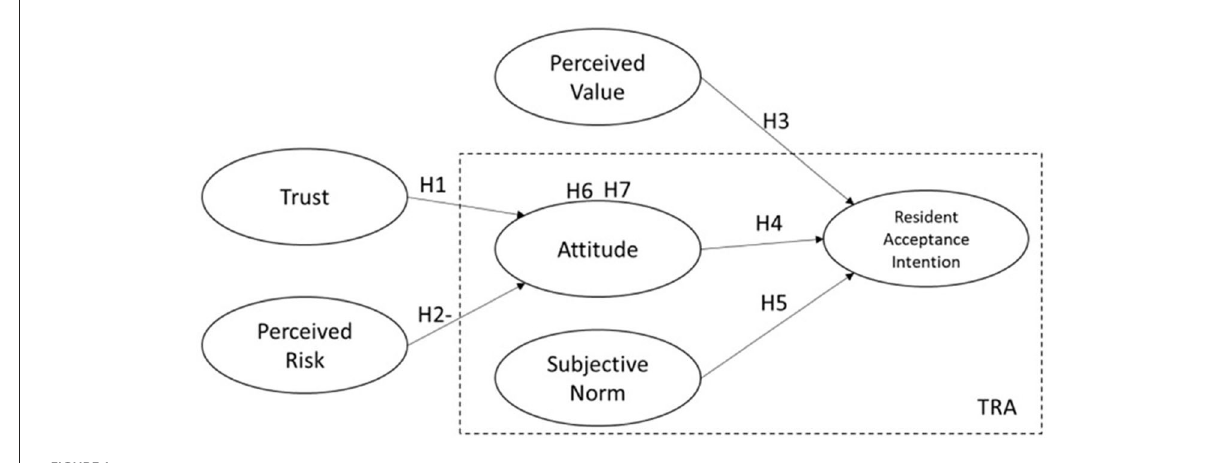
FIGURE1 The theoretical